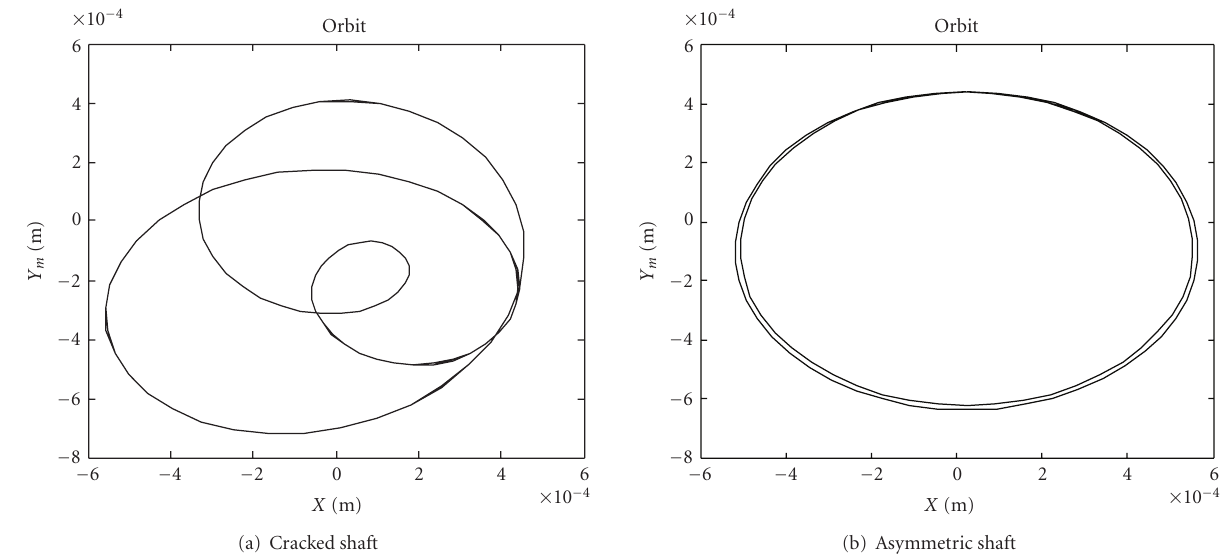
Figure 8: Shaft whirling at Ω = ω n / 3; ω t /ω n = 1 . 38; ω n = 2400 rpm, Table 3 parameters.